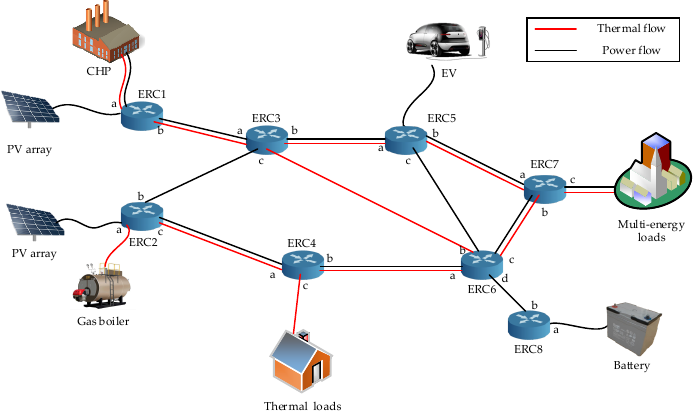
Figure 3. An example structure of an energy internet containing multiple energy routing centers.